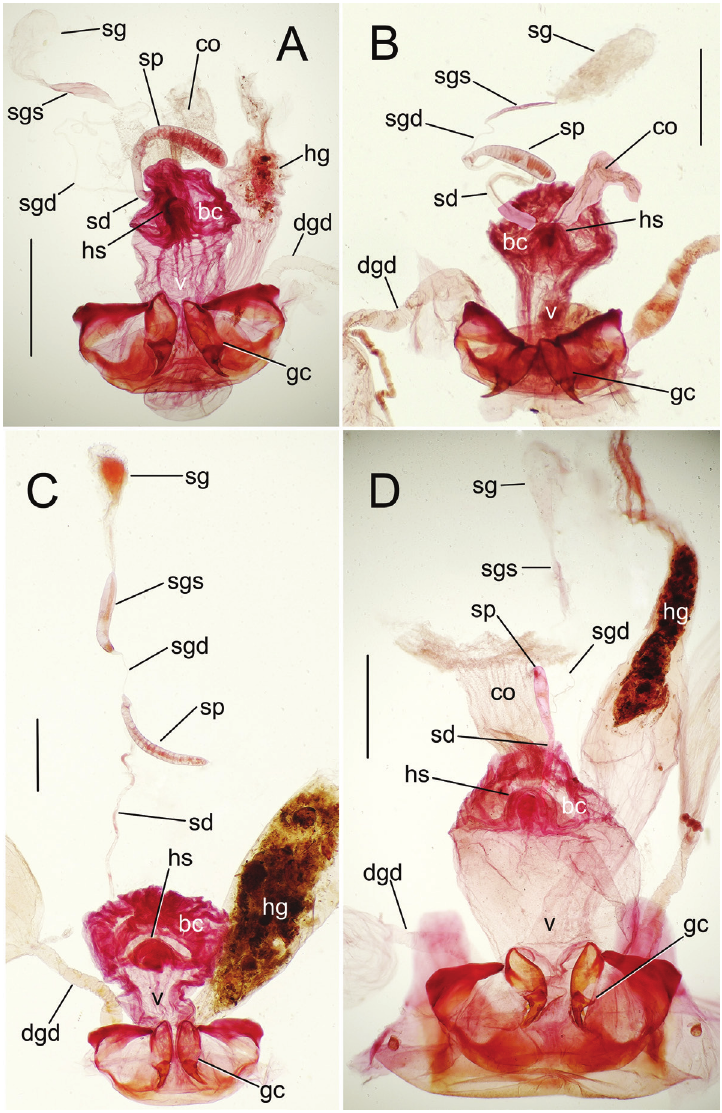
Figure 7. Female reproductive tract of Theprisa spp., ventral view A T. otway B T. convexa C T. montana D T. australis . Abbreviations: bc, bursa copulatrix; co, common oviduct; dgd, defensive gland efferent duct; gc, gonocoxa; hg, hindgut; hs, helminthoid sclerite; sd, spermathecal duct; sg, spermathecal gland; sgd, sper- mathecal gland duct; sgs, spermathecal gland stem; sp, spermatheca; v, vagina. Scale bars: 0.50 microtrichia visible in uneverted specimens (Fig. 3C), and covering much of right side of internal sac ventrad flagellar complex (Fig. 4C); flagellum elongate, robust, with a broad base; right paramere elongate, evenly narrowed in apical half to rounded tip (Fig. 5C), bearing 6–17 short setae along ventral margin in apical half, 4–8 setae on